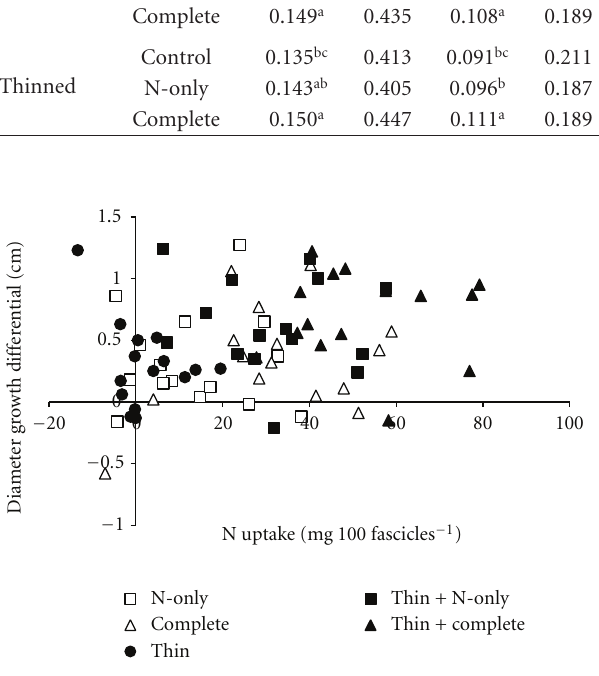
Figure 4: Diameter growth di ff erential of thinning and fertilization treatments relative to the controls in relation to nitrogen uptake by the foliage in year 1 (N content of treated trees—N content of control trees). Diameter growth di ff erential is the di ff erence between DBH growth after three years of the treated stand and DBH growth of the associated control